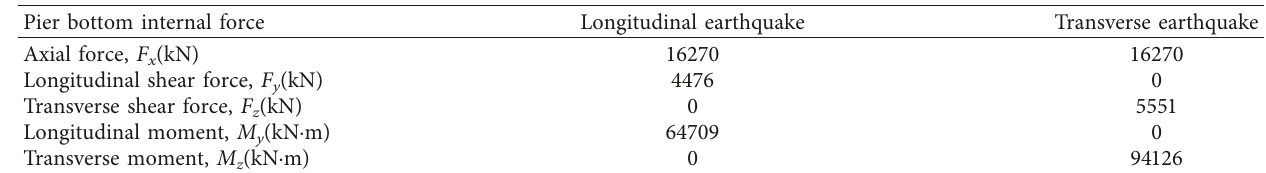
Table 4: Pier bottom internal forces under low-level